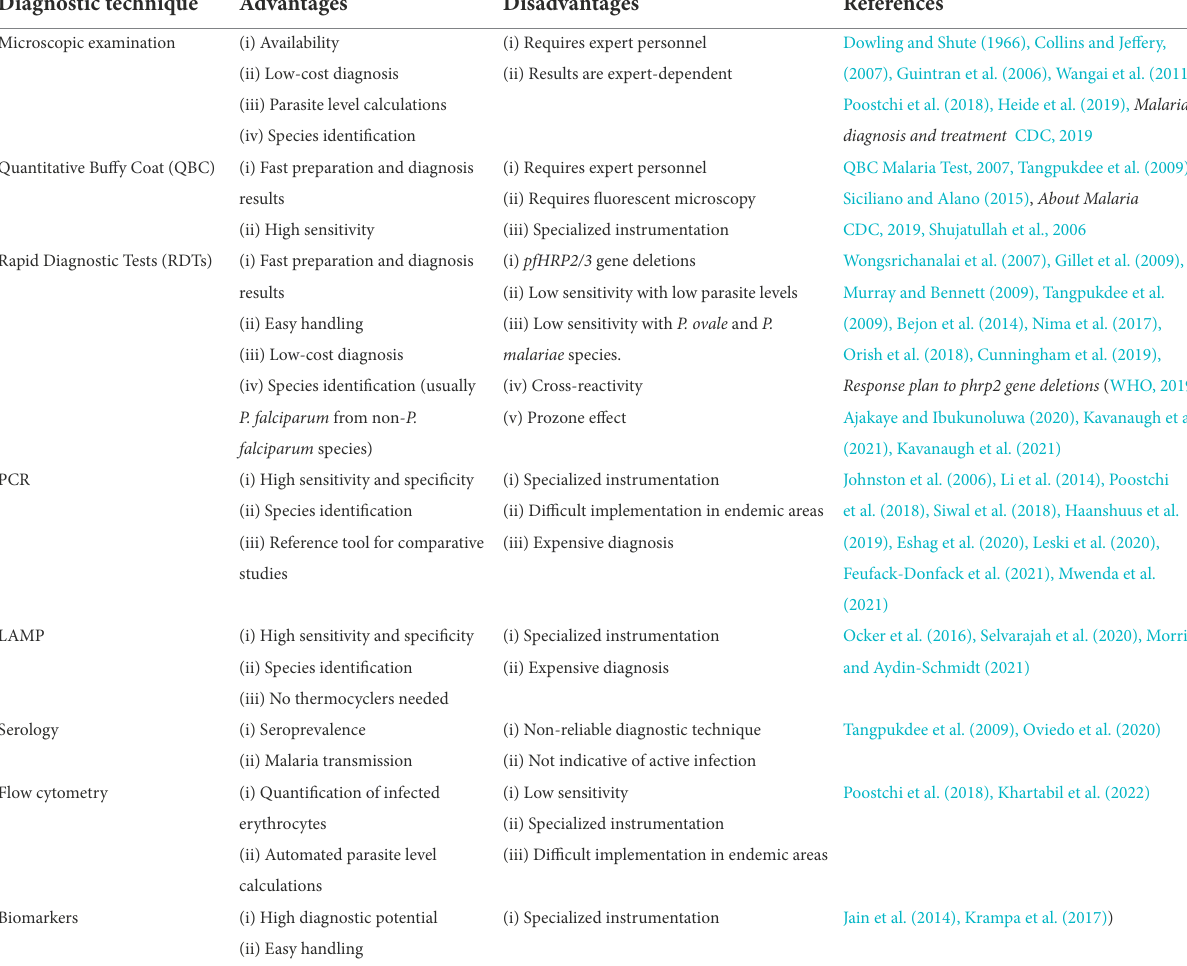
TABLE 1 Advantages and disadvantages of malaria diagnostic